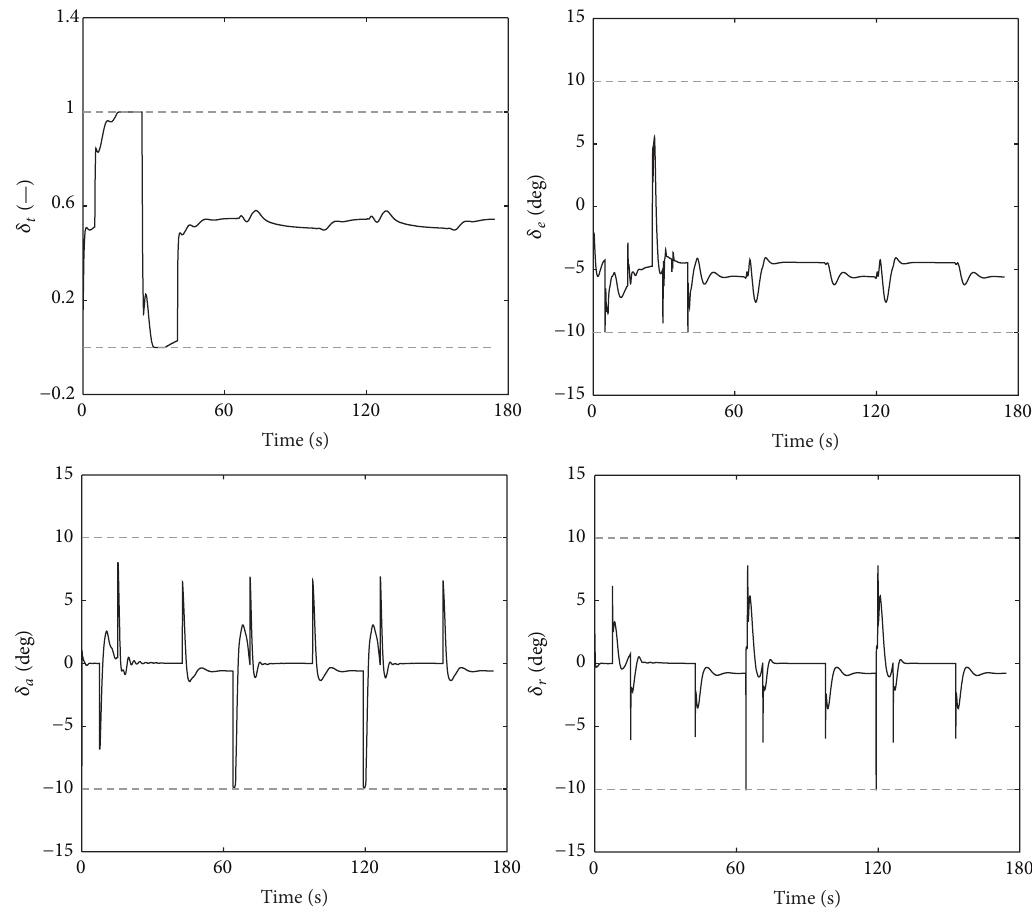
Figure 6: Inputs in the nominal